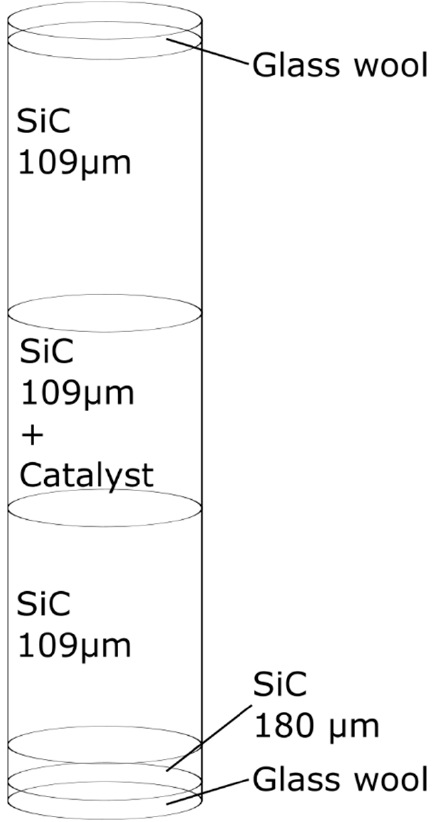
Figure 12. Schematic of the reactor loading of different SiC sizes (average particle diameter) and catalyst. The bed section that contains catalyst bed is positioned in the middle of the reactor and is approximately 7 cm long.